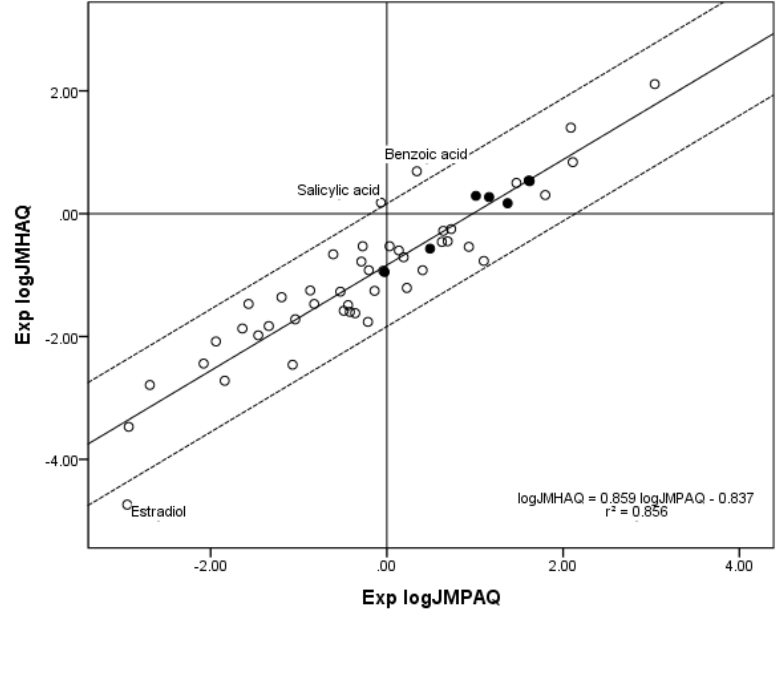
Figure 5. The correlation of the n = 52 log J lines represent the boundaries for residual Exp. log J line is the regression equation. The filled circles indicate the n = 7 phenols. The regression information is in the